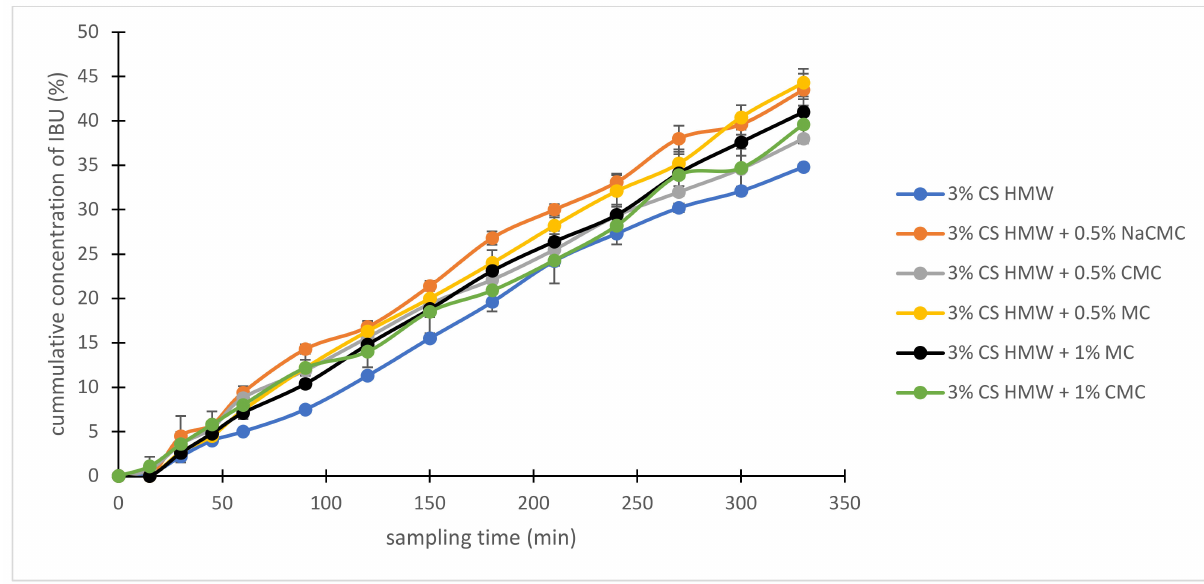
Figure 7. The cumulative amount of IBU released from chosen combinations of hydrogels with time.